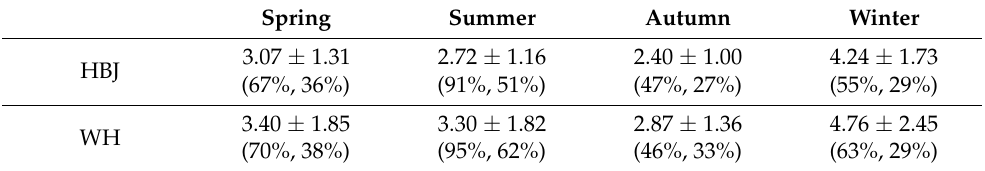
Table 5. Concentration ( µ g · m − 3 ) and contribution of SOC PMF-based to WSOC and OC (%). Spring Summer Autumn Winter